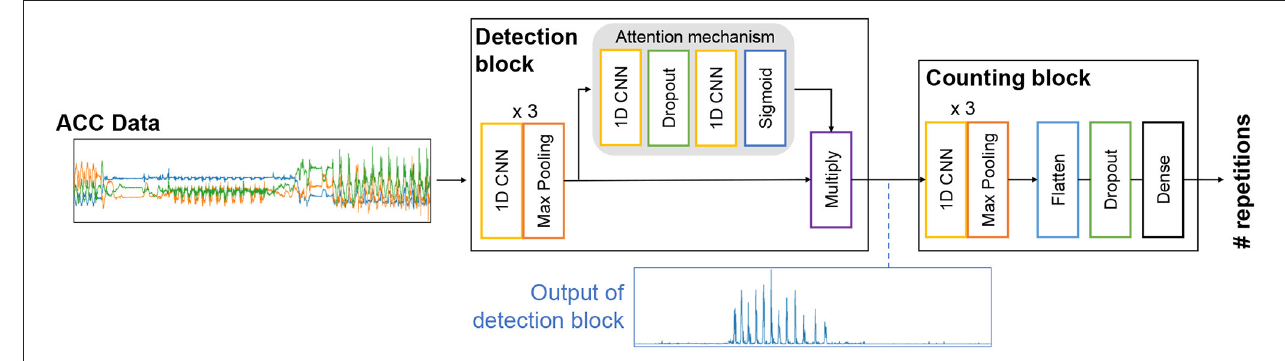
FIGURE 5 | Architecture of WeakCounter-Net.